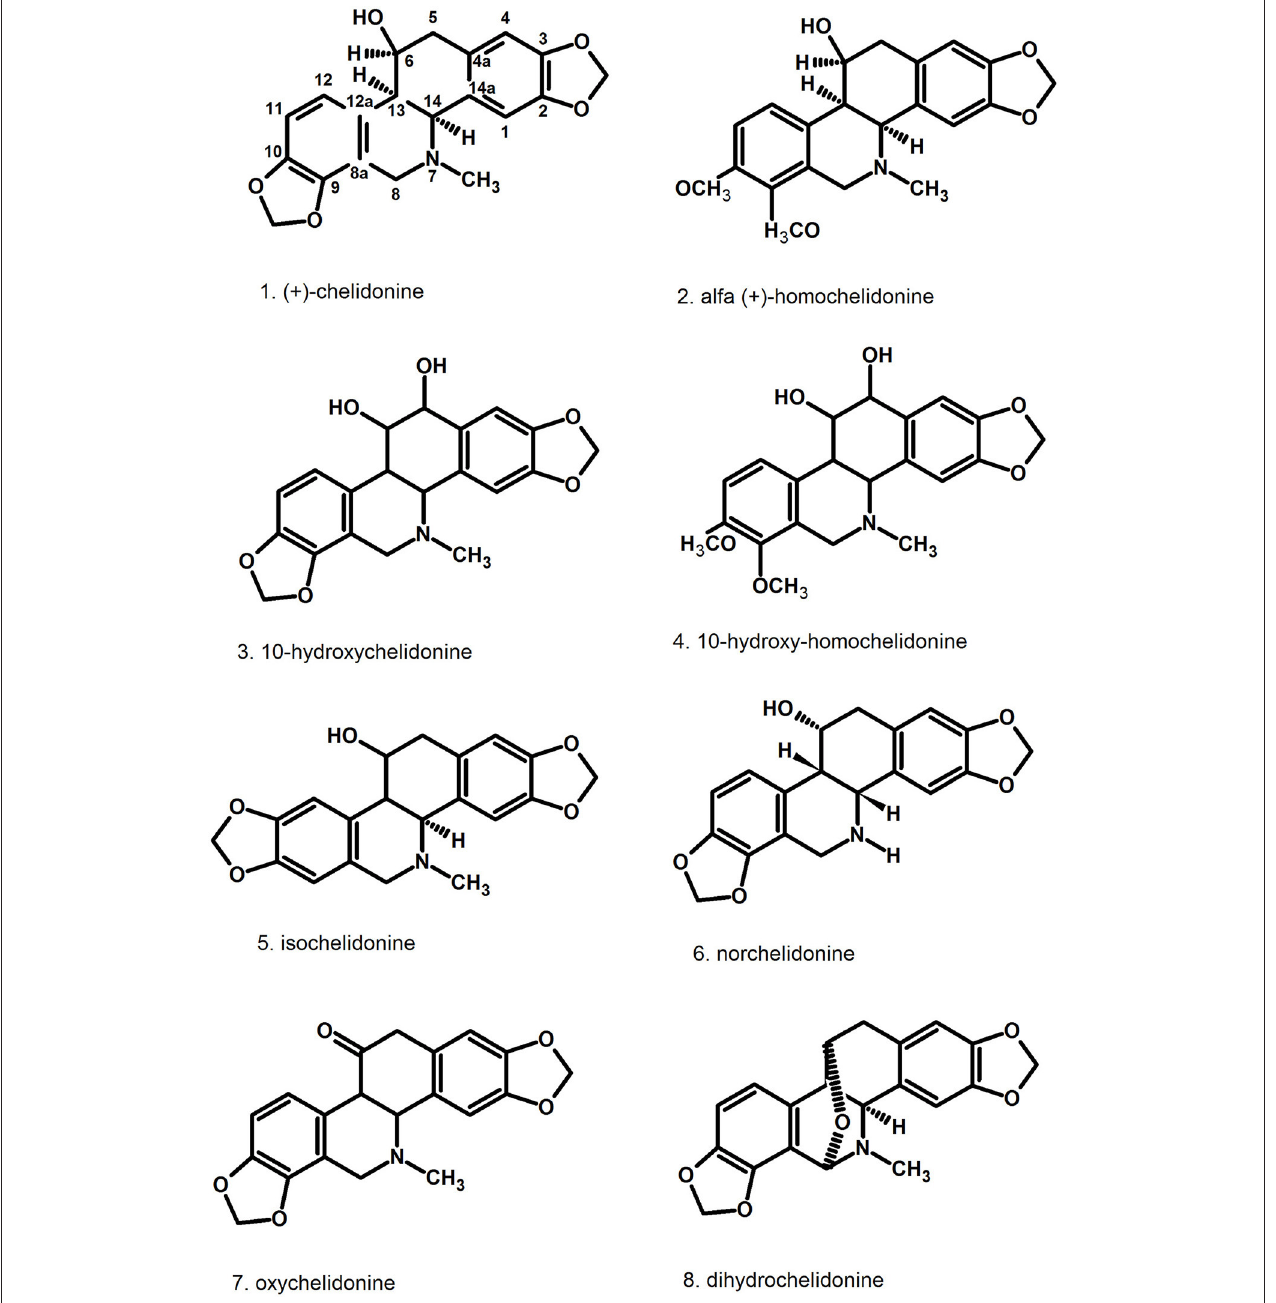
FIGURE 1 | Structures of phenanthridine (3,4-benzoisoquinoline) alkaloids—chelidonine [1]